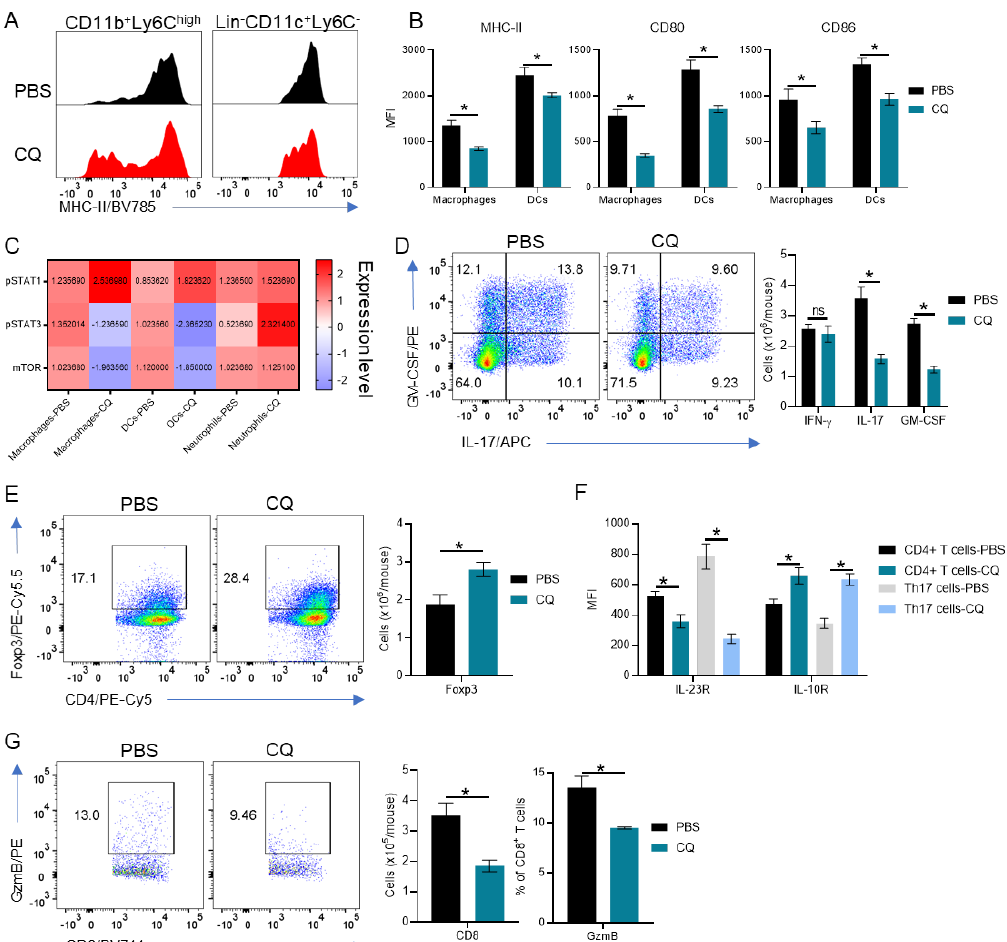
Figure 2. Comprehensive analysis of the immune compartment in the central nervous system (CNS) of CQ-treated mice. CNS cells from EAE B6SJLF1 mice ( n = 5 / group) at day 21 post-immunization were analyzed by flow cytometry. ( A ) Representative histogram for MHC-II expression in CD11b + Ly6C high macrophages and in Lin - CD11c + Ly6C - DCs. ( B ) MHC-II, CD80 and CD86 expression in macrophages and dendritic cells (DCs). ( C ) Mean fluorescent values for pSTAT1, pSTAT3 and mTOR in macrophages, DCs and Ly6G + neutrophils were measured by flow cytometry. ( D ) Infiltrating GM-CSF-, IFN- γ and IL-17-producing CD4 + T cells in the CNS of EAE mice. ( E ) Numbers of Foxp3 + Treg cells. ( F ) Analysis of IL-23R and IL-10R in total CD4 + T cells and in Th17 cells in the CNS of EAE mice. ( G ) Analysis of total CD8 + T cell GzmB-producing CD8 + T cell infiltration in the CNS of EAE mice. Values of p < 0.05 (*) were considered statistically significative. Ns: not significative. Results are from three independent experiments.